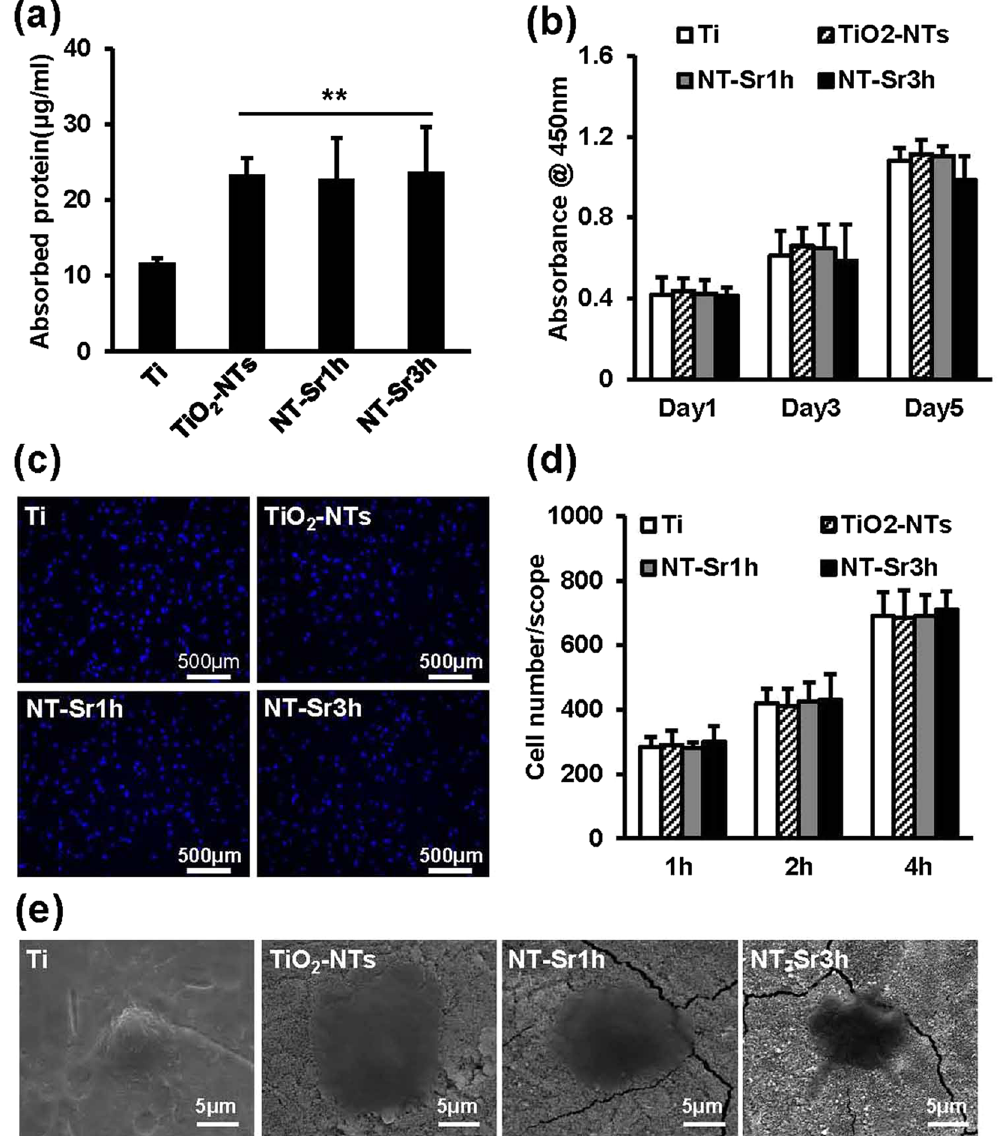
Figure 2. Biological properties of the samples. ( a ) Protein adsorption on different samples after immersion in α -MEM for 2 h. ( b ) RAW264.7 cell proliferation on the specimens after 1, 3, or 5 d of culture. Cell proliferation was measured by CCK-8. ( c ) After incubation for 2 h, RAW264.7 cells stained with DAPI. The scale bar represents 500 μ m. ( d ) Initial adherent cell numbers at 1, 2, or 4 h. ( e ) After culturing for 2 d, the morphology of RAW264.7 cells on different samples was assessed by SEM images. The scale bar represents 5 μ m. ** p < 0.01 compared with the Ti group. At least three independent experiments were analysed, and the data are presented as the means ±